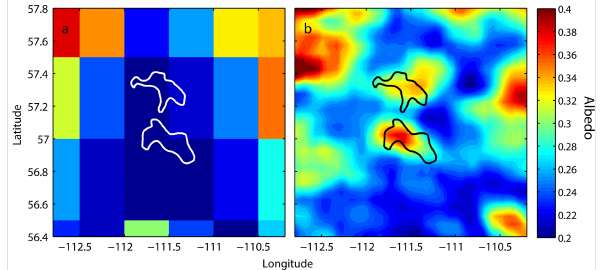
Fig. 5. Snow albedo over the oil sands surface mining region: (a) from OMI at 354nm and on a 0.5 ◦ × 0.5 ◦ grid (O’Byrne et al., 2010) and (b) from MODIS at 477nm smoothed to 30km ×